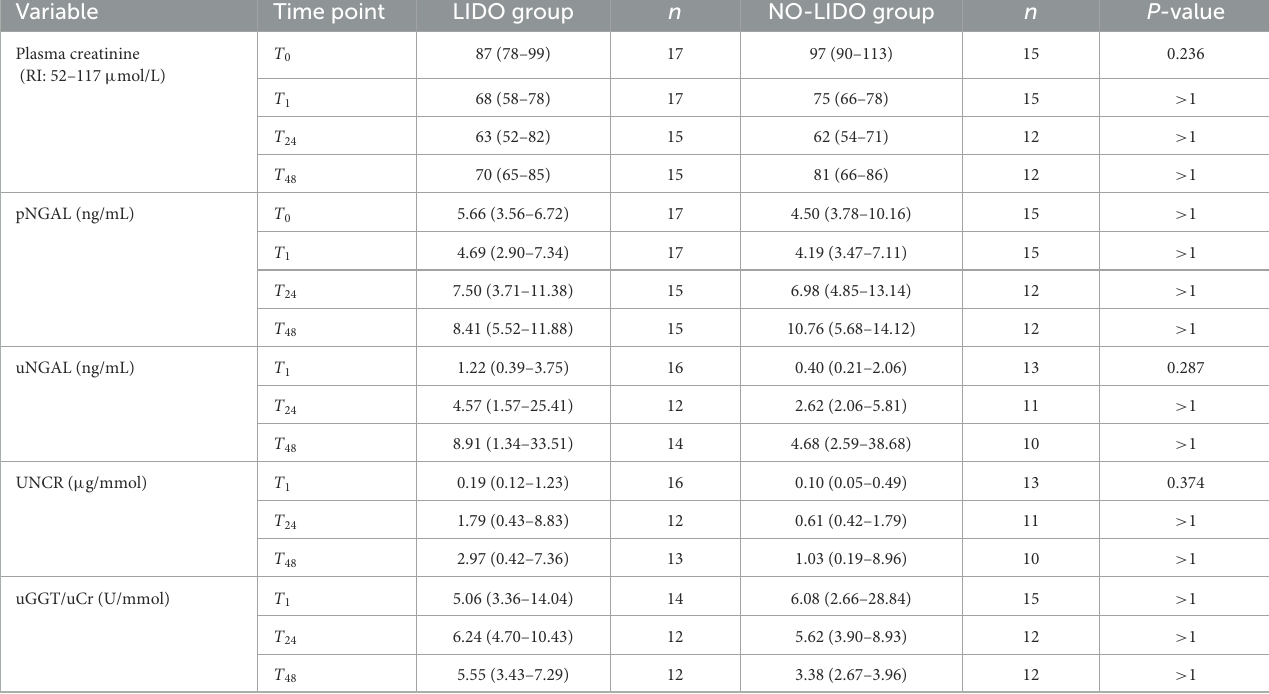
TABLE 4 Median (IQR) of plasma and urinary renal markers in dogs with GDV treated with lidocaine (LIDO group) or without lidocaine (NO-LIDO group). Variable Time point LIDO group n NO-LIDO group n P- value Plasma creatinine (RI: 52–117 µ